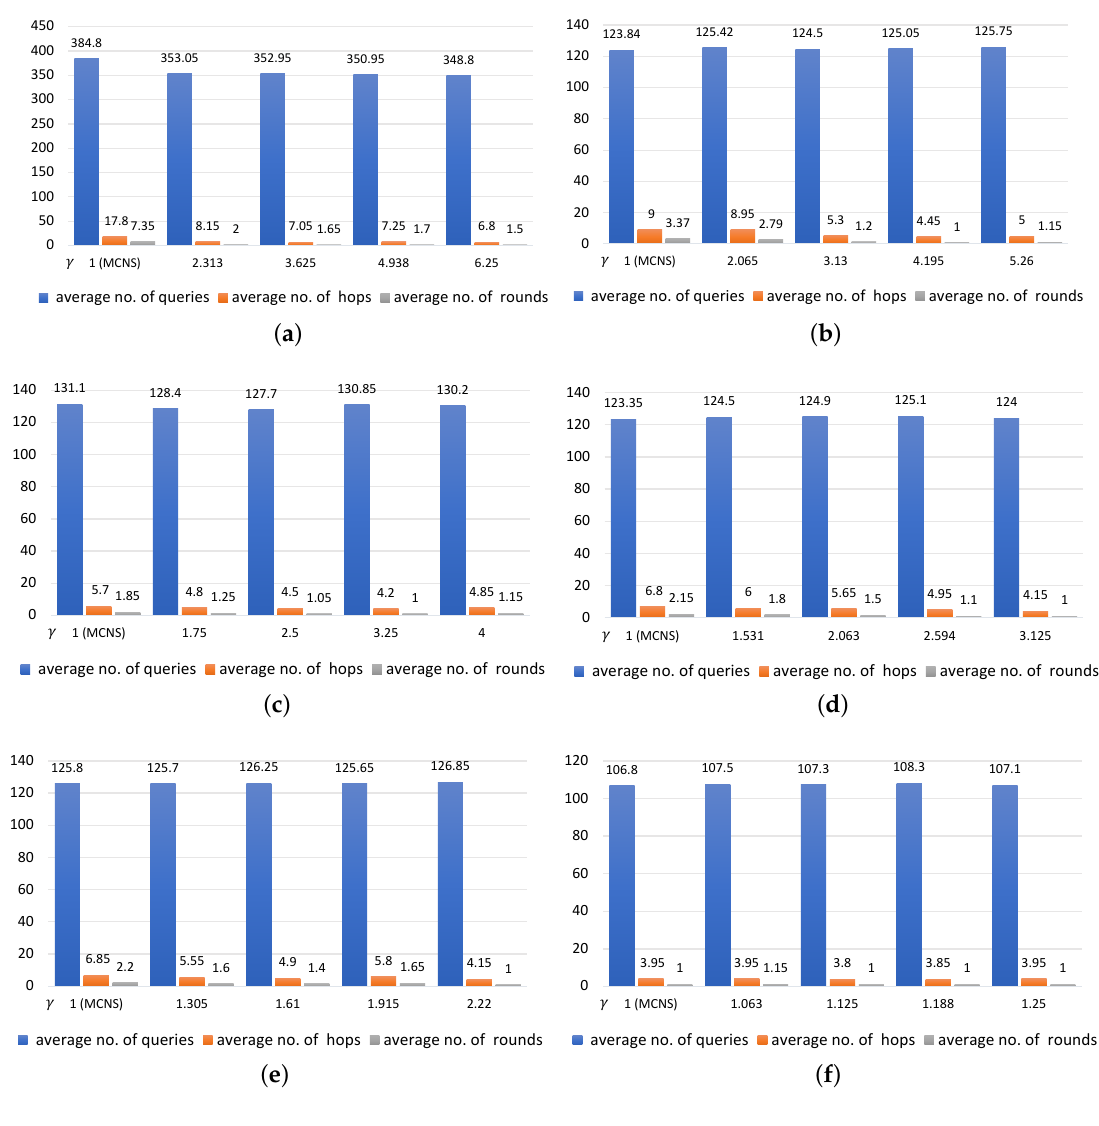
Figure 8. Comparing MCNS and MCNS-G: the number of queries sent to regions and number of hops and number of rounds averaged over 20 runs (vertical axis) for varying γ (horizontal axis) for different values of σ with k = 100. ( a ) σ = 0.16 ( α = 0.20 , β = 0.80 ) ; ( b ) σ = 0.19 ( α = 0.75 , β = 0.25 ) ; ( c ) σ = 0.25 ( α = 0.50 , β = 0.50 ) ; ( d ) σ = 0.32 ( α = 0.80 , β = 0.40 ) ; ( e ) σ = 0.45 ( α = 0.60 , β = 0.75 ) ; ( f ) σ = 0.81 ( α = 0.90 , β = 0.90 )